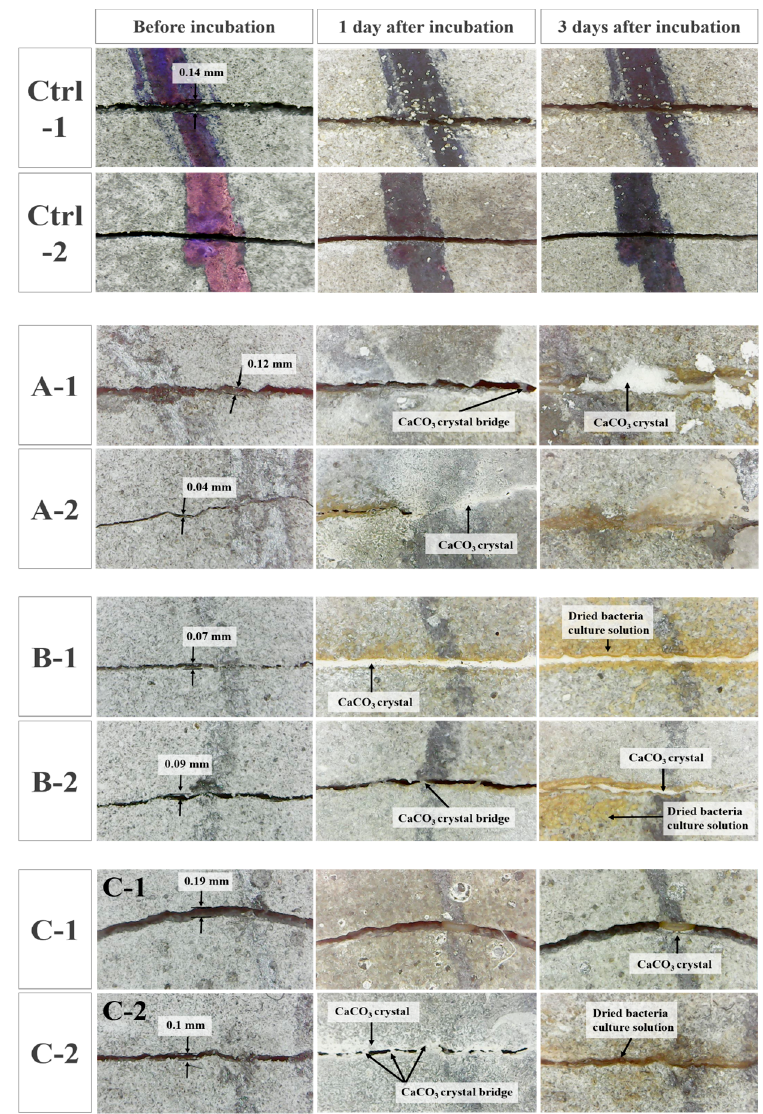
Figure 10. Microscopic observation of crack healing after one and three days of incubation.